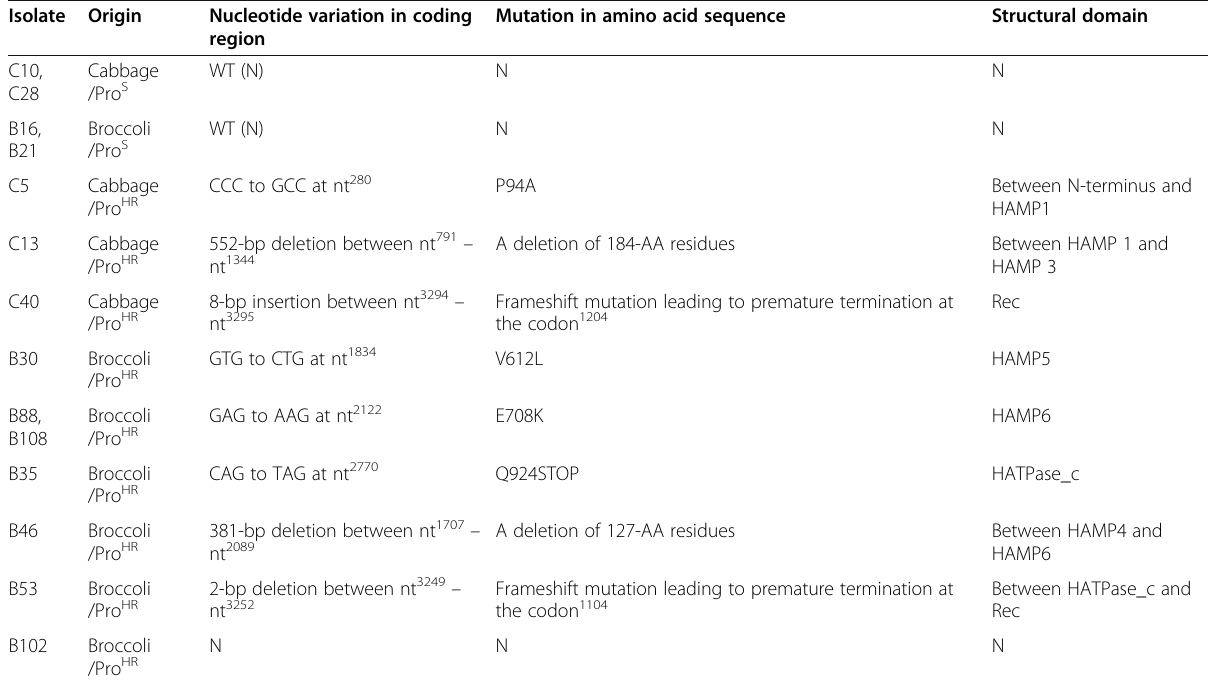
Table 4 Mutations in the coding regions of AaHK1 from Alternaria alternata Pro HR and Pro S isolates Isolate Origin